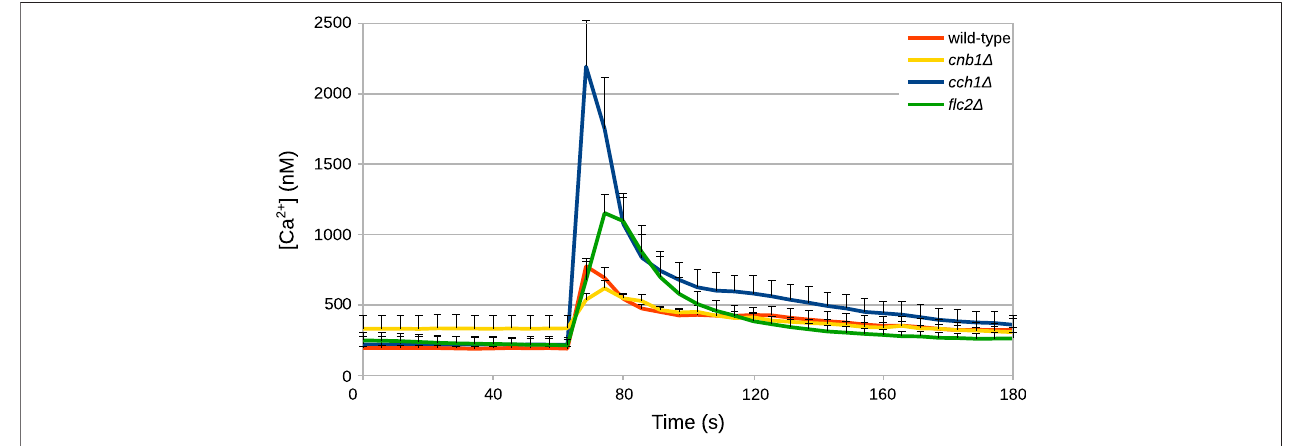
FIGURE2| Exampleoftimetraces ofcytosolicCa 2+ concentrationin S.cerevisiae cellschallengedwithHTS.HTSwasappliedbydilutingthegrowthmedium with four volumes of distilled water at t =60. The fi nal concentration of Ca 2+ in the medium was 5.9 μ M. Time traces were taken from Rigamonti et al. (2015) and from Tisi R., unpublished results.